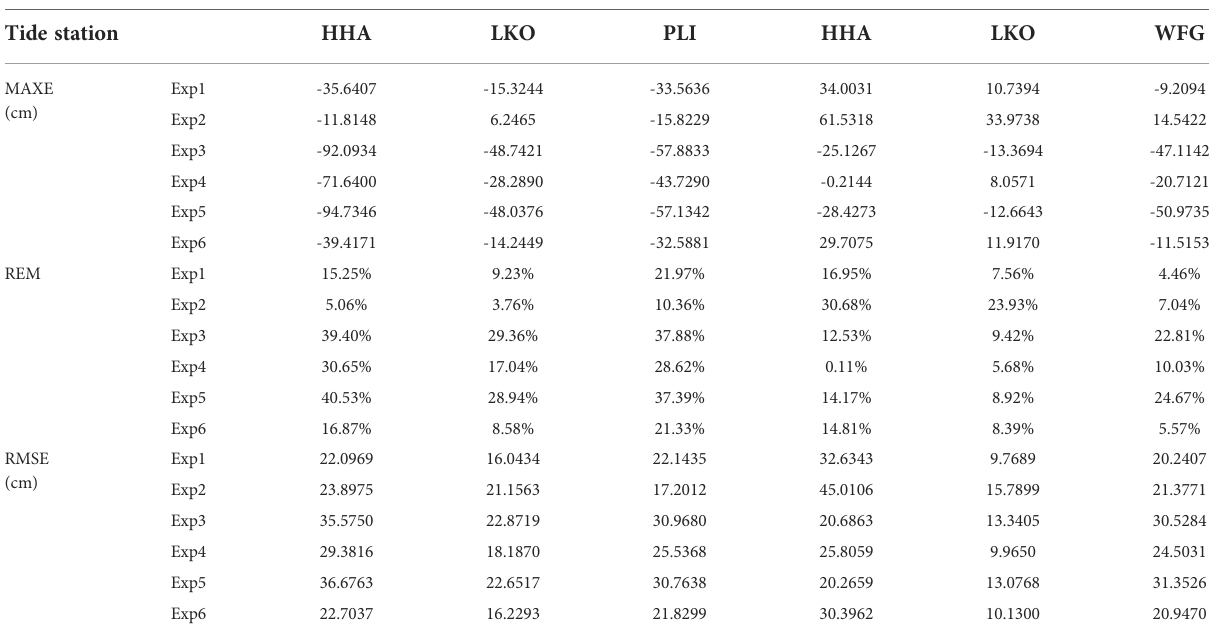
TABLE 2 Error metrics of storm surge.